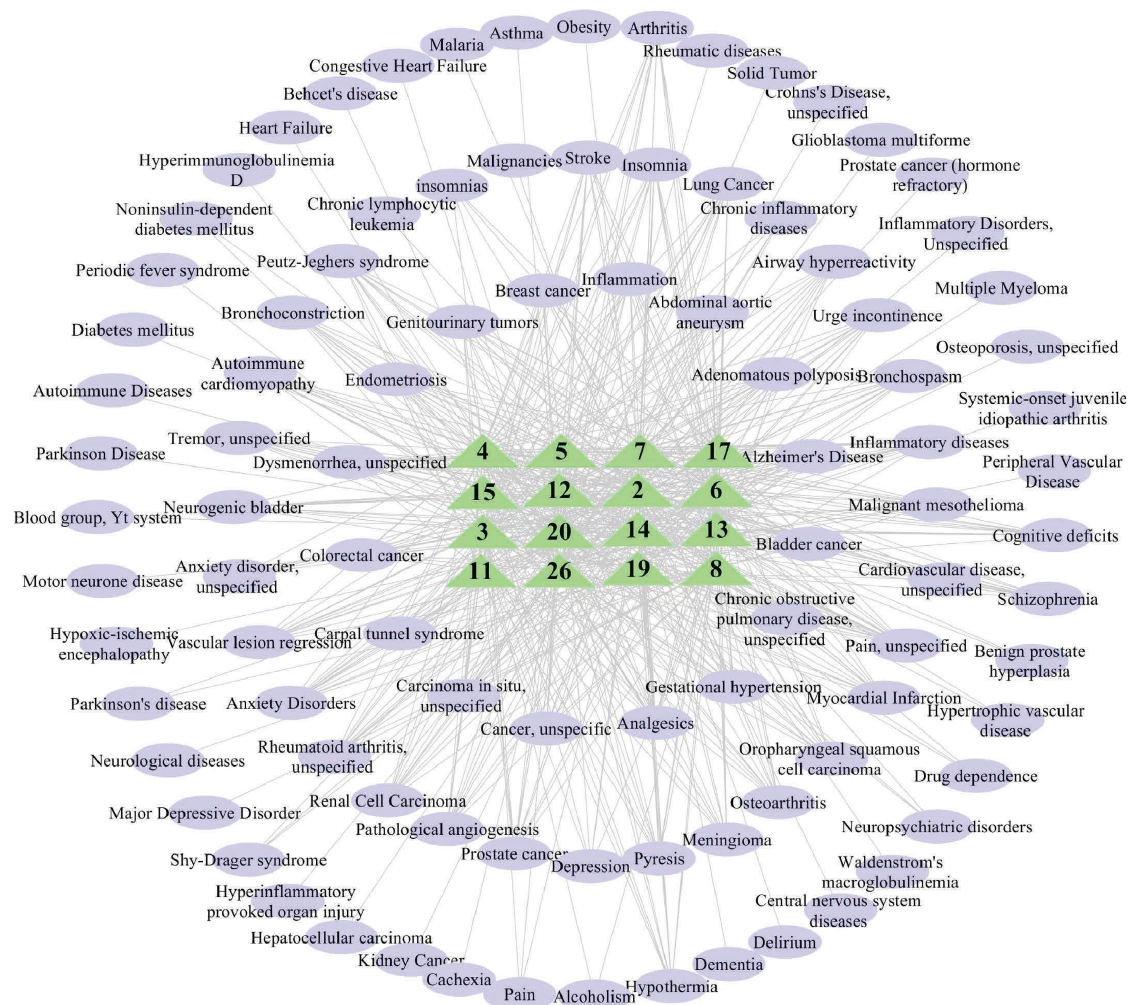
Figure 7: Network diagram based on 26 identifed common diferential compounds of VOCs and related diseases. Te number including 2 , 3 , 4 , 5 , 6 , 7 , 8 , 11 , 12 , 13 , 14 , 15 , 17 , 19 , 20 , and 26 , indicating that the identifed common diferential compounds of VOCs in GFs of various ages have related diseases; green represents the diferential compounds and purple represents the related diseases. Among them, alzheimer’s disease, infammatory diseases, and prostate cancer are the top 3 related